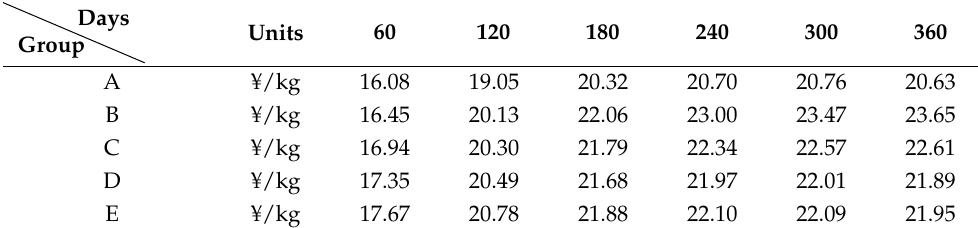
Table 6. Economic profit of